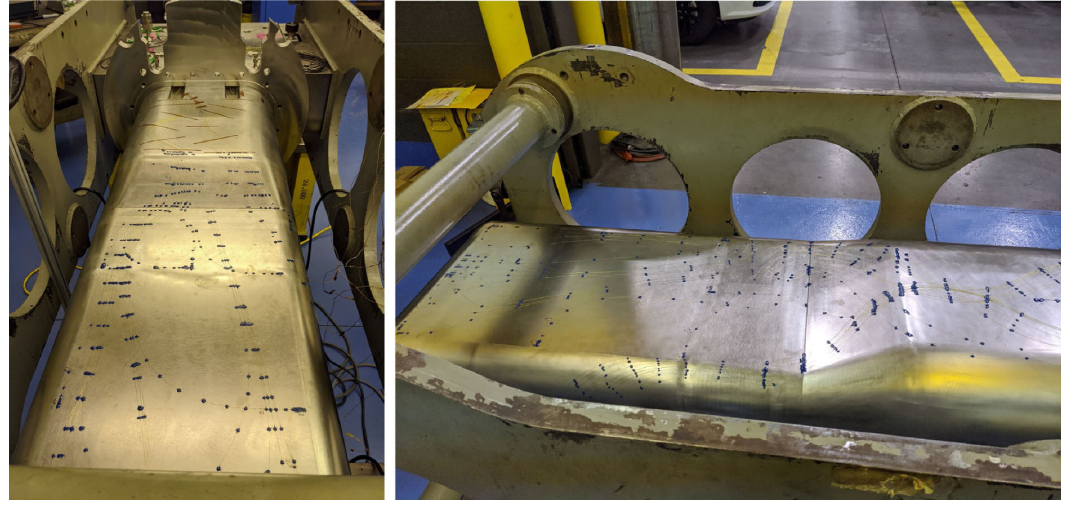
FIG. 6. Fiber sensors mounted on the surface of the mercury vessel of the SNS target for strain measurement.